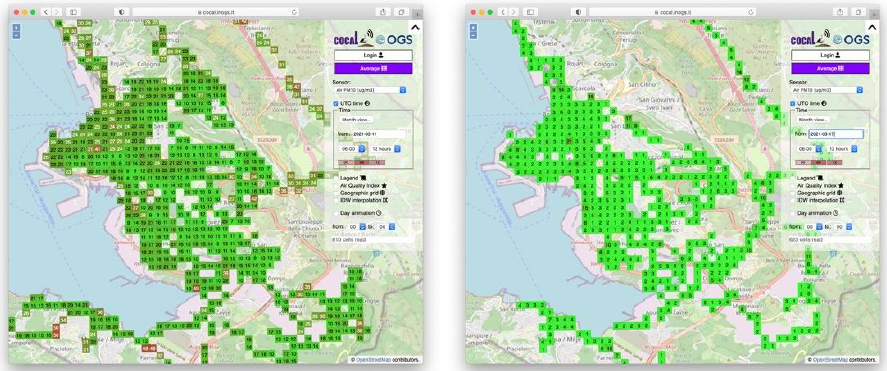
Figure 8. Comparison between the air quality before 11 March 2021 and during 17 March 2021 (the COVID-19 lockdown was issued on 15 March 2021).